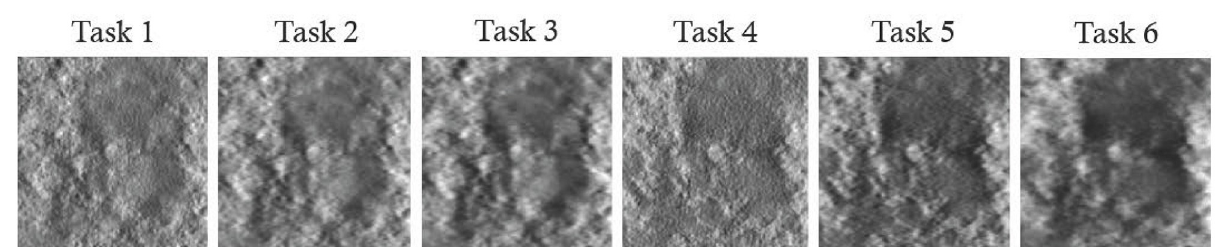
PLOS ONE | https://doi.org/10.1371/journal.pone.0229915 March 12,